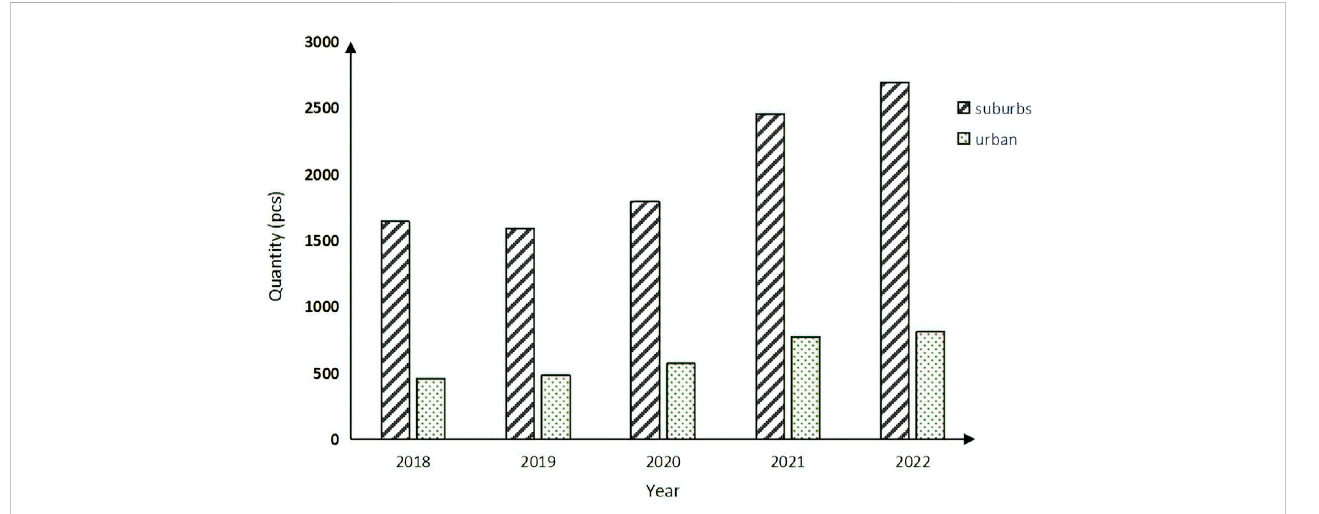
FIGURE 3 Difference in the number of water-polluting enterprises in Zhejiang Province between urban and suburban areas from 2018 to